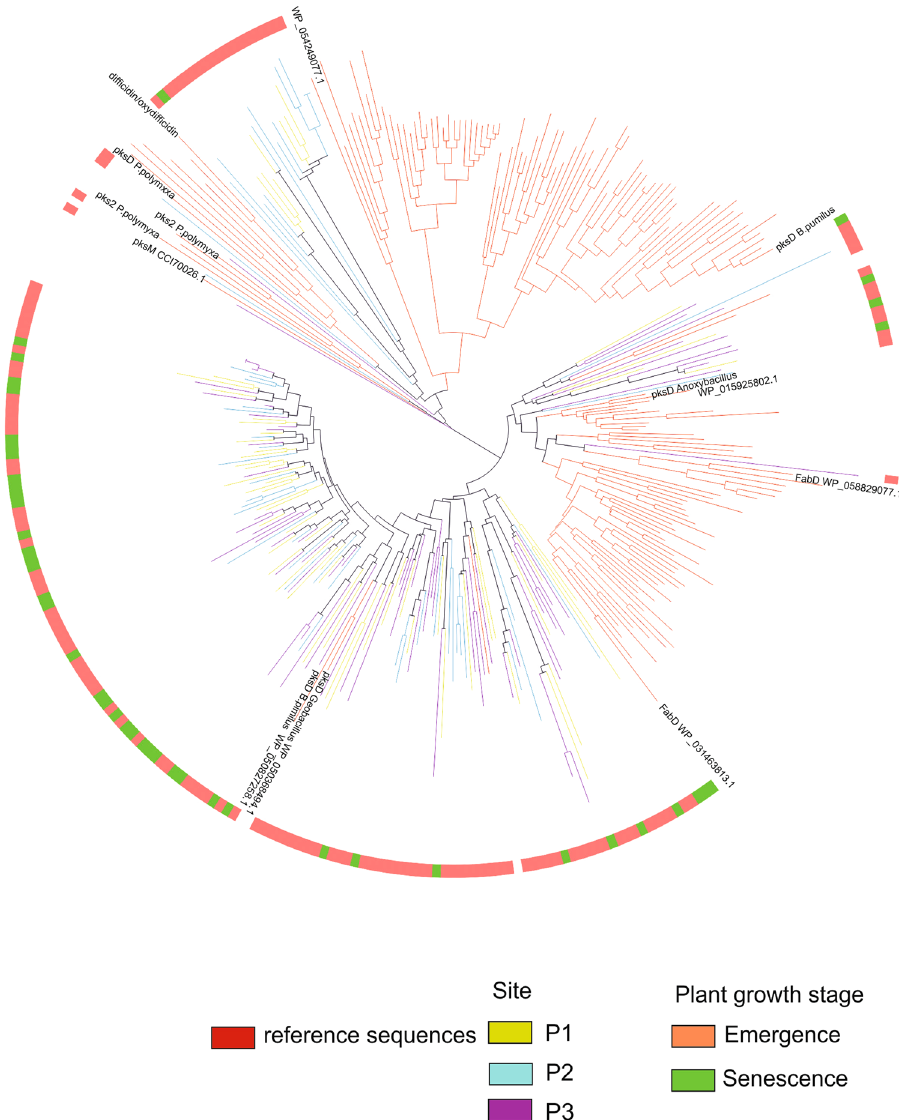
Figure 1. Phylogenetic tree showing the distribution of PKS sequences from Firmicutes. ACP DNA sequences were clustered at 85% sequence identity and subsequent representative sequences from OTUs were aligned in ClustalW and neighbor-joining tree was displayed in iTOL2. Branches of reference sequences were colored bright red, rhizosphere soil sequences were colored by site (P1, P2 and P3), and outer ring was colored according to plant growth stage (emergence and